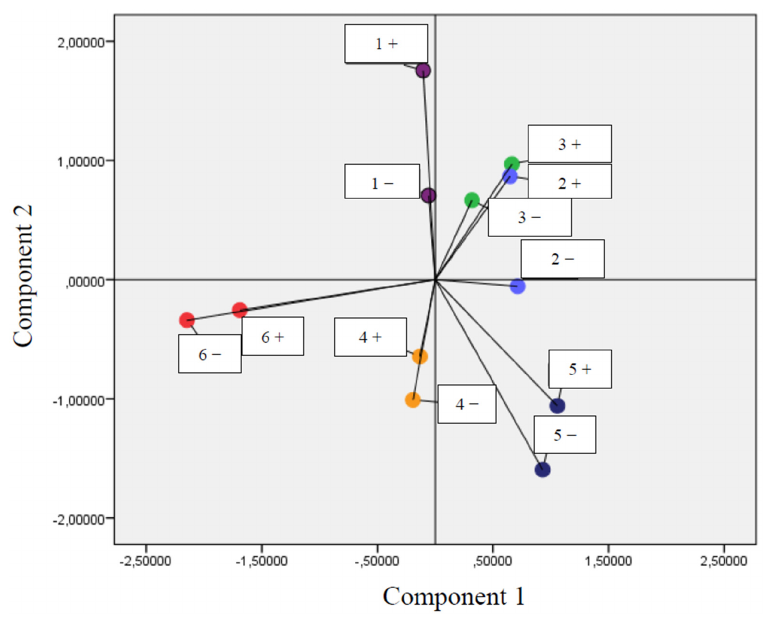
Figure 1. Distribution of fruit wines according to the two components (Lievito Secco yeast, 1—blueberry, 2—black chokeberry, 3—blackberry, 4—raspberry, 5—cherry, and 6—apple; + with sugar and enzyme, − without sugar and enzyme).